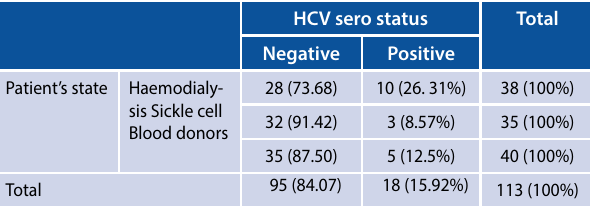
X 2 = 4.82, df = 2, p =